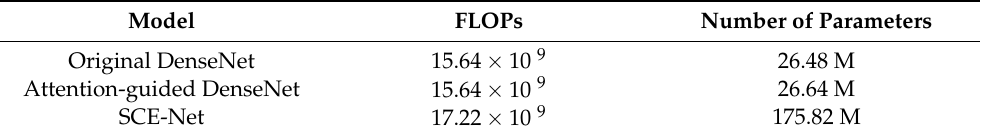
Table 11. Comparison of the FLOPs and number of parameters of the original DenseNet, attention- guided DenseNet, and